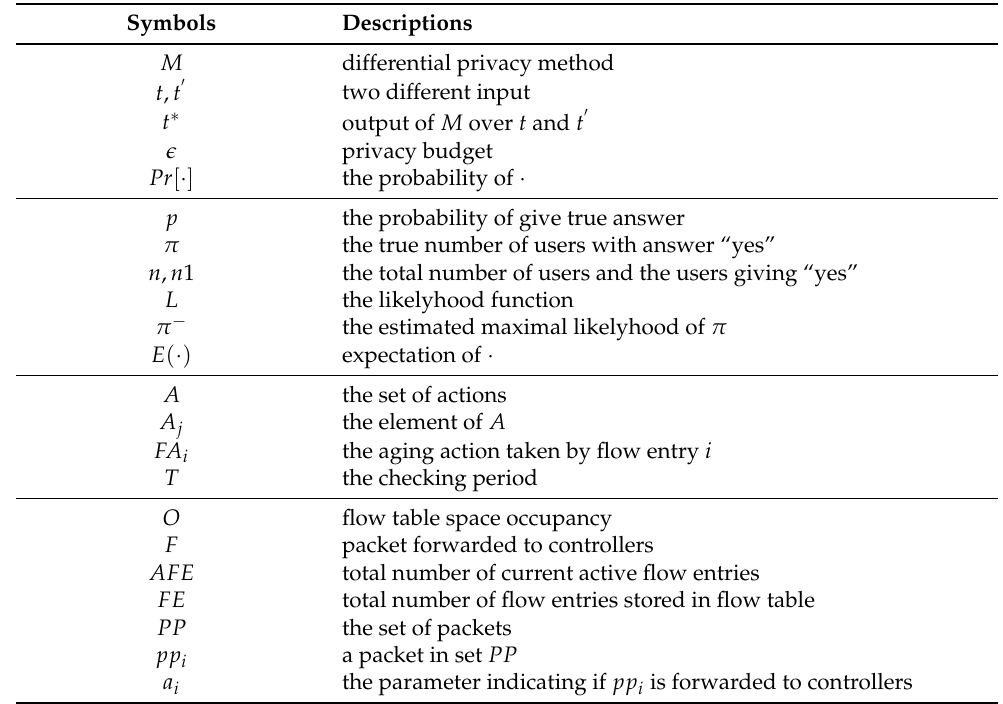
Table 2. Symbols and their